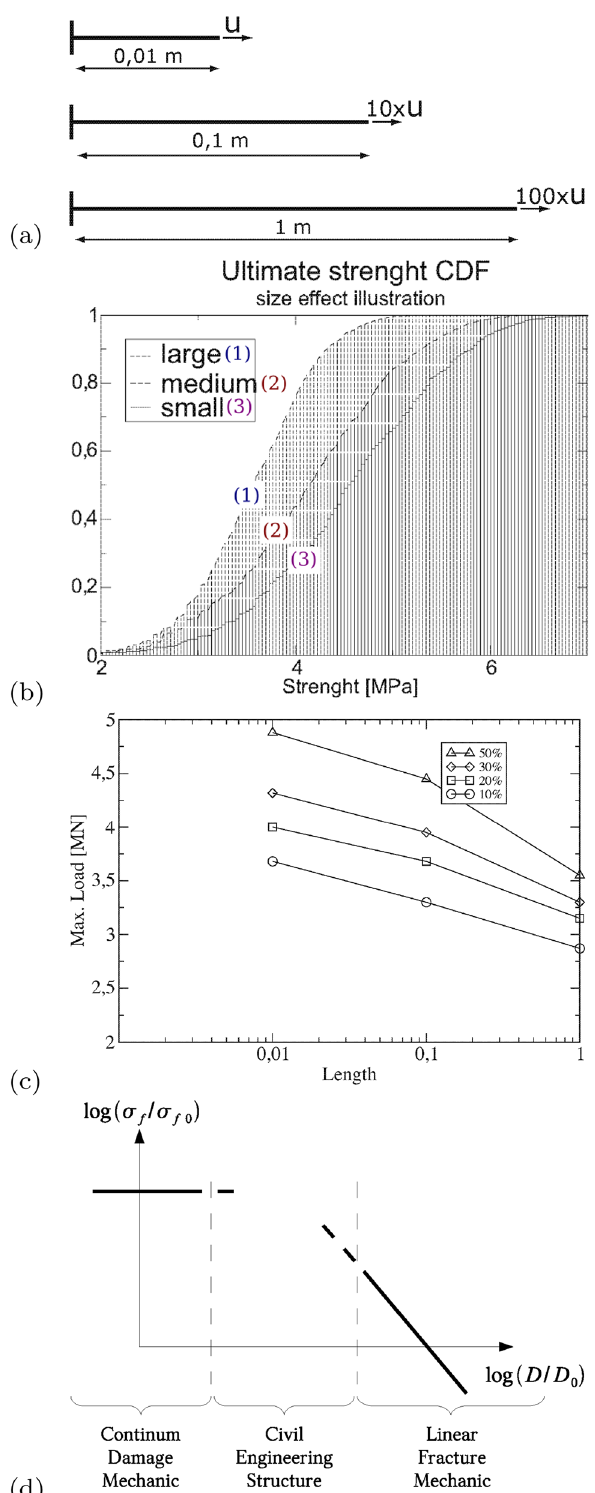
Fig. 26 a Classification of three bars with respect to correlation length L c : short (1 L c ), medium (10 L c ) and large (100 L c ); b ultimate strength CDF; b probability-based explanation of size effect [35] illustrated with percentile of broken bars and d deterministic illus- tration of size effect